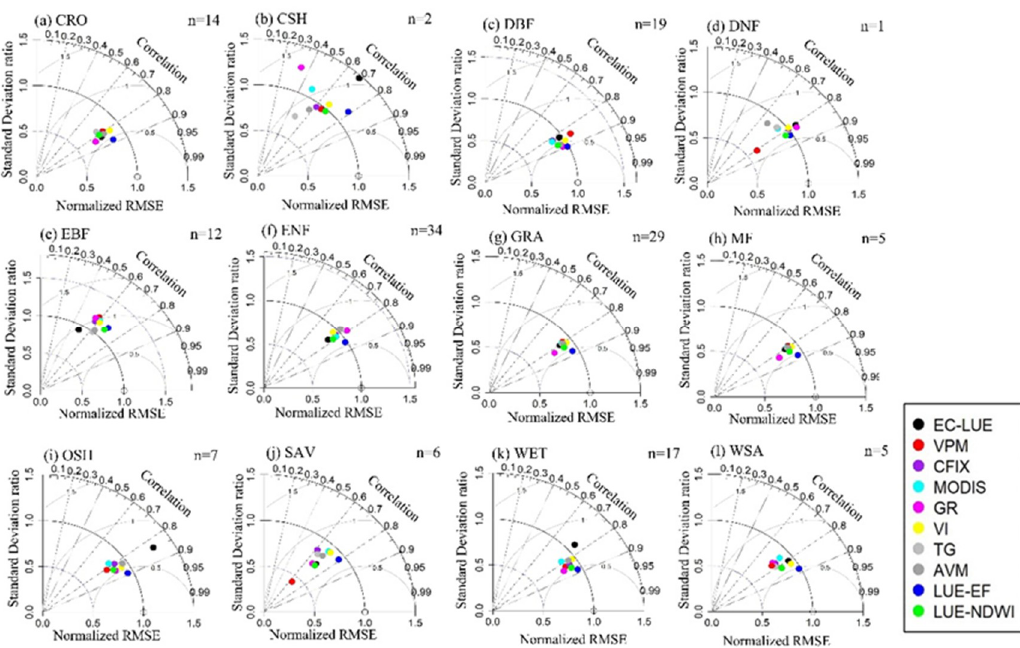
Figure A1. The Taylor diagram showing the overall performance of all models under different biomes. The color dots represent the models in the corresponding legend. The Taylor diagram is a polar graph in which the cosine of the angle between the X -axis is the correlation coefficient between the GPP of the model and EC − tower. The radial direction is the ratio of model to EC − tower GPP standard deviation. The grey arcs represent the RMSE normalized by standard deviation for each model. The n is the number of EC-towers. Where ( a – i ) contains 12 terrestrial biomes: CRO (croplands), CSH (closed Shrublands), DBF (deciduous broadleaf forest), DNF (deciduous needleleaf forest), EBF (evergreen broadleaf forest), ENF (evergreen needleleaf forest), GRA (grasslands), MF (mixed forests), OSH (open shrublands), SAV (savannas), WET (permanent wetlands), WSA (woody savannas).